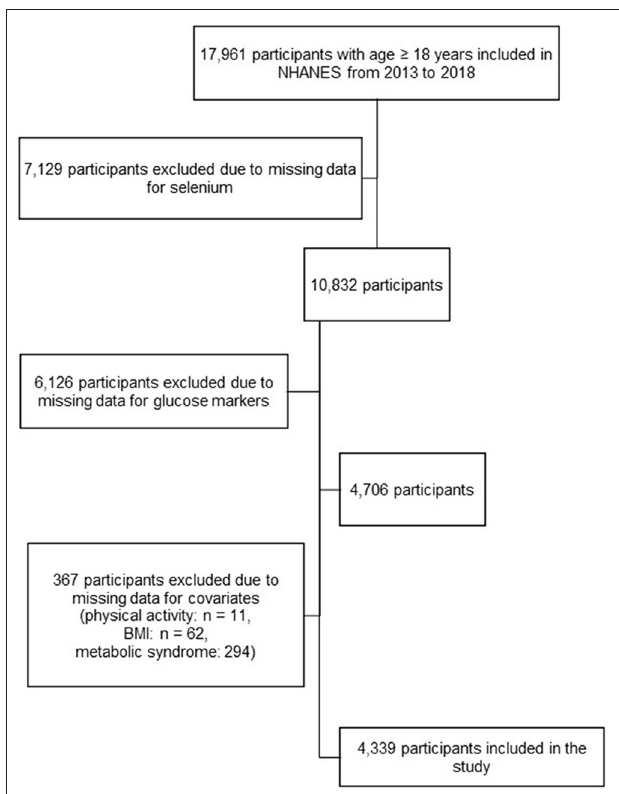
FIGURE 1 | Selection of the study population, from the National Health and Nutrition Examination Survey (NHANES) from 2013 to 2018.